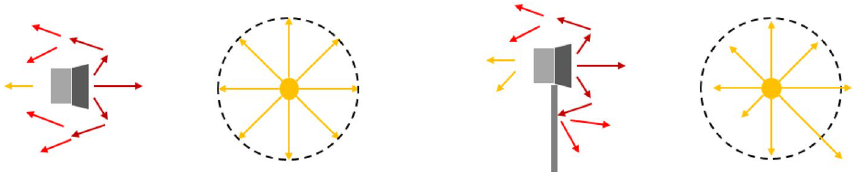
Figure 2. Configuration of the generated sound by a speaker in the free field (left) and a speaker with a barrier